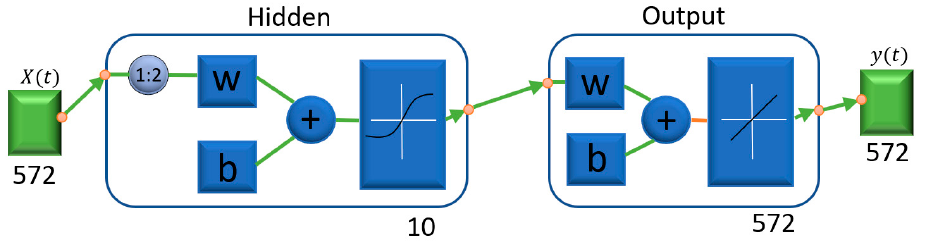
Figure 1. NARX network-based fault detection scheme .